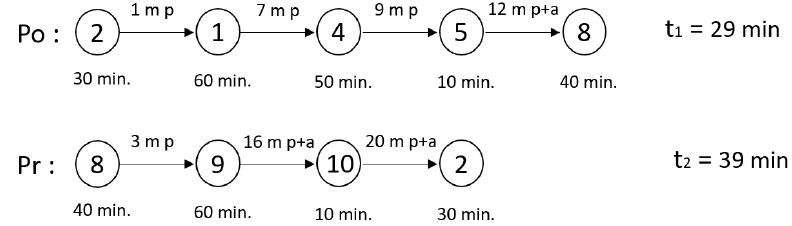
Figure 14. The Graphs G o and G r and the travel times t 1 and t 2 .